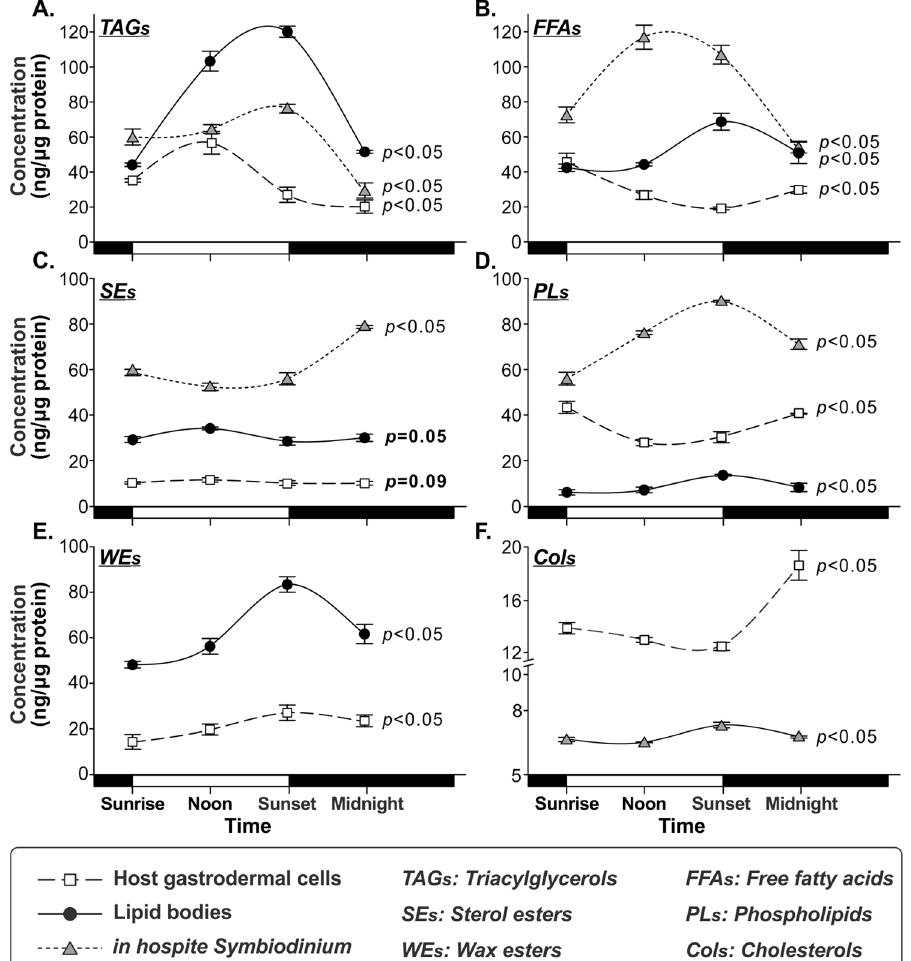
Figure 3. Different variation of individual lipid concentrations. ( A ) TAGs, ( B ) FFAs, ( C ) SEs, ( D ) PLs, ( E ) WEs, and ( F ) Cols (please see main text for full names) among host coral gastrodermal cells (hollow squares), lipid bodies (solid circles), and in hospite Symbiodinium populations (gray triangles) over the diel cycle (mean ± SD, n = 4). In the x-axis, the light/dark period indicates in the open (day time) and closed (night time)